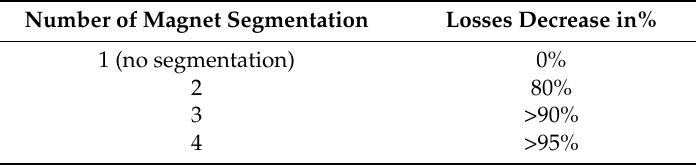
Table 4. The segmentation of magnets and its impact on losses mitigation when the machine acts as generator and feeds a rectified load (Results reproduced with the permission of the authors: D. Gerling [52]).